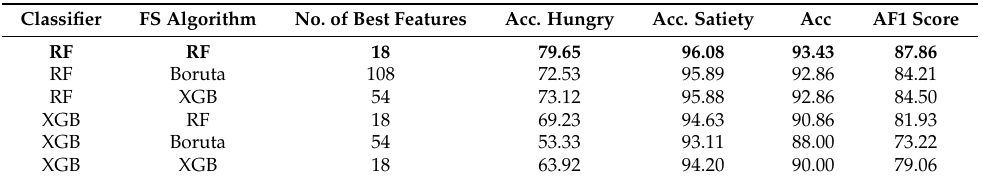
Table A1. Results of the classification of hunger and satiety using RF and XGB classifier based on the best features selected with Boruta, XGB, and RF.